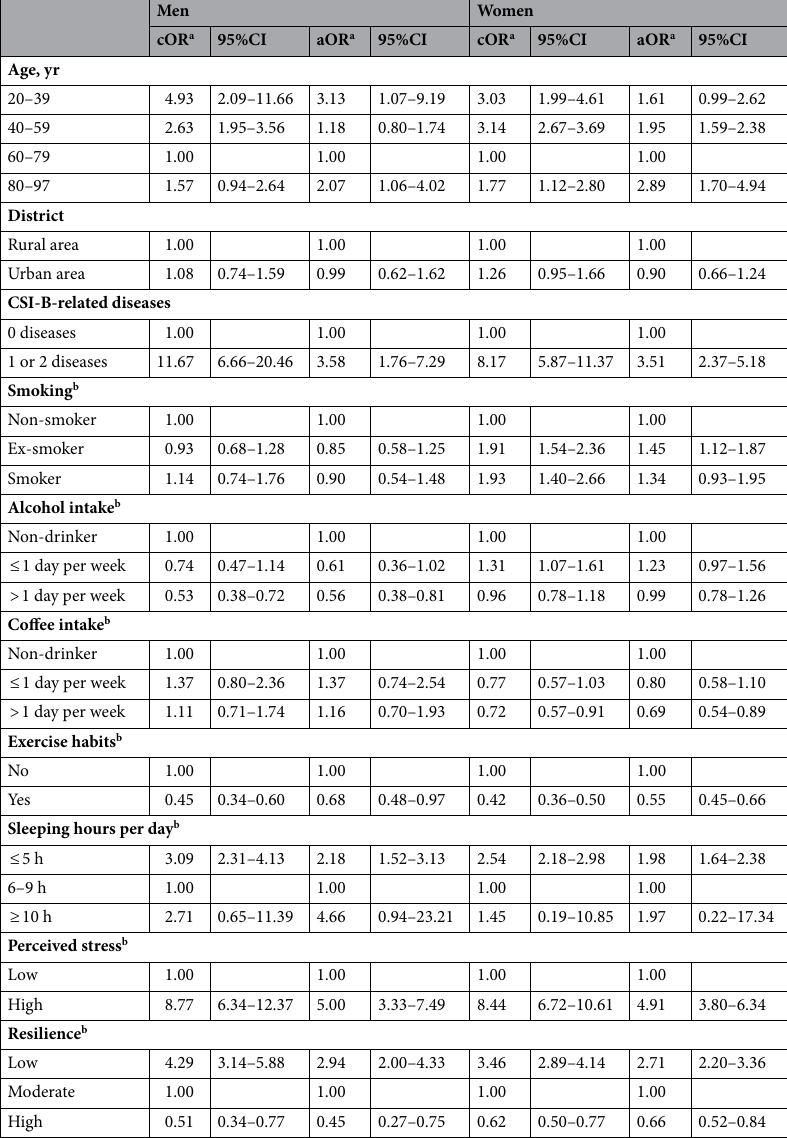
Table 3. Relationships between the prevalence of CSS with CSI-A ≥ 40 points and factors by sex. a cOR and aOR mean crude and adjusted odds ratios analyzed with univariate and multivariable logistic regression models. b Participants with missing values for smoking (n = 494), alcohol intake (n = 1522), coffee intake (n = 3761), exercise habits (n = 458), sleeping hours per day (n = 69), perceived stress (n = 198), and resilience (n = 120) were